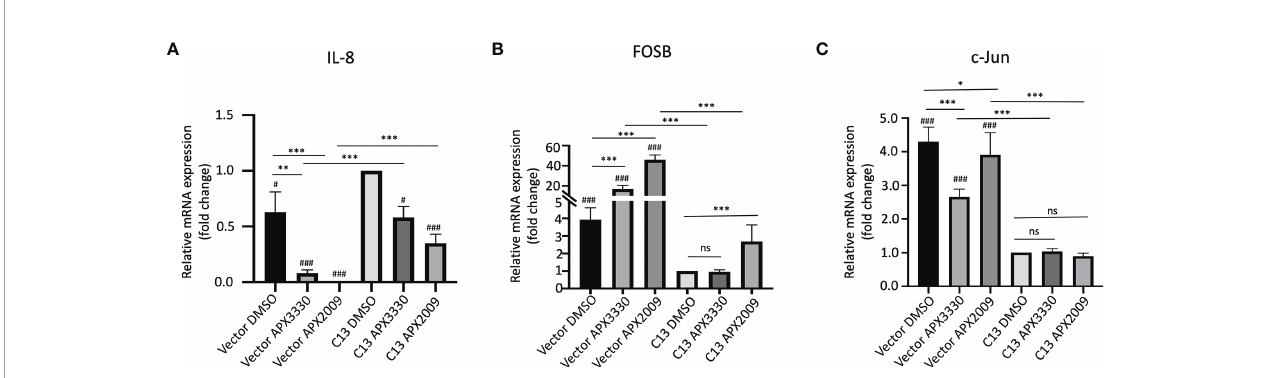
FIGURE 2 | Ref-1 inhibitors suppress in fl ammatory responses via RelA mediated pathways. KC3590 cells that are RelA de fi cient (Vector) and clone with functional RelA add back (C13) were challenged with Ref-1 inhibitors, APX3330 (60 m M Vector; 30 m M C13), APX2009 (16 m M Vector; 6 m M C13) based on their EC50 for 24 hours. The effects of Ref-1 inhibitors on mRNA expression levels of IL-8, FOSB, c-Jun was assessed with qPCR (Figure (A – C) , respectively). Six independent experiments were performed (n = 6). Hashtag “ # ” is comparing to C13 DMSO, # p < 0.05, ### p < 0.0001; *p < 0.05, **p < 0.01, ***p < 0.0001, ANCOVA, N=6. “ ns ” , not signi